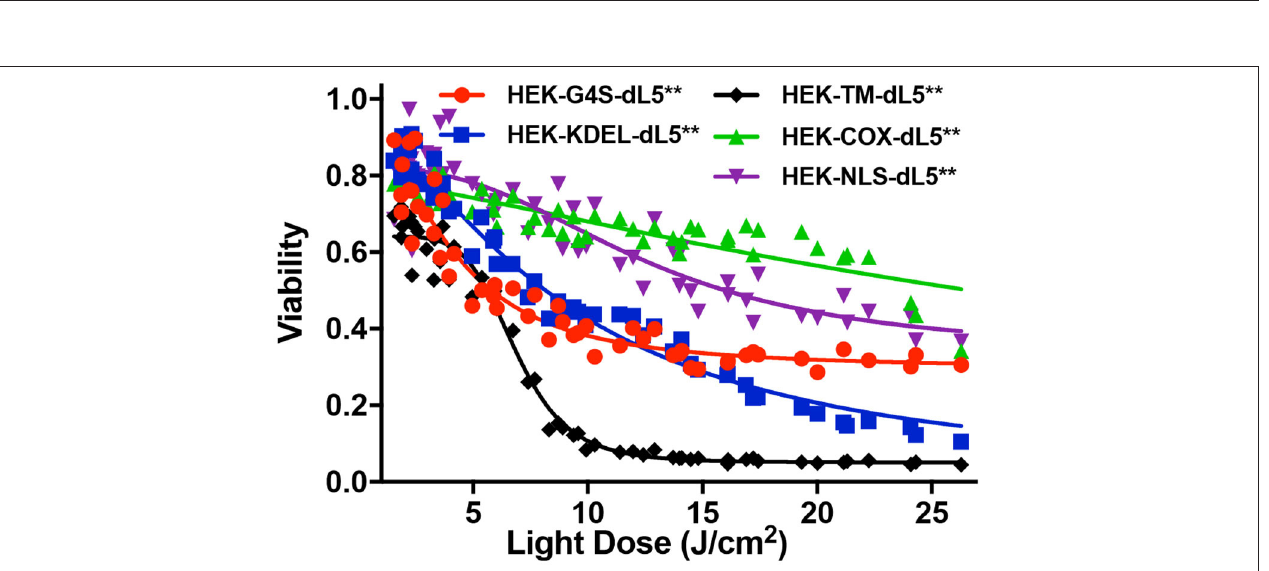
FIGURE 3 | MTS cytotoxic assay of five different dL5**-expressing HEK cells incubated with MG2-Iester (500nM, NIR 660-nm illumination, 45s). All plates were treated consistently, with in-plate controls for no photosensitization (no dye: viability = 1), complete cytotoxicity (70% ethanol: viability = 0), and normalized viability plotted for the appropriate photo-exposure of the given